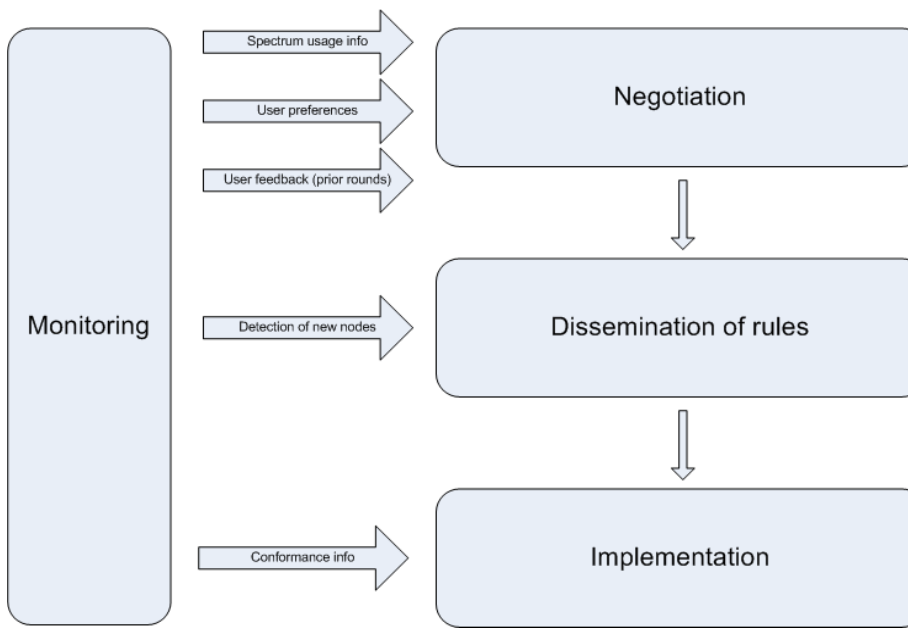
Figure 1. Spectrum sharing